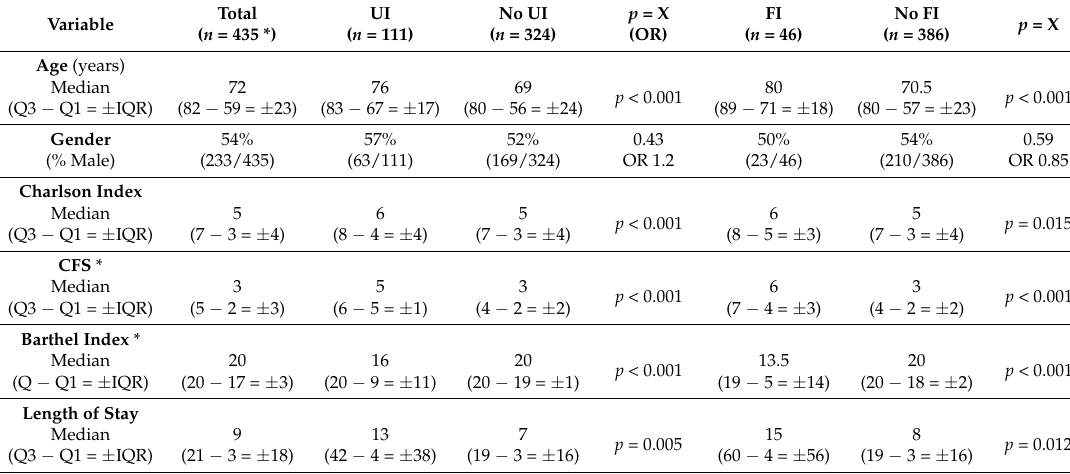
Table 1. Baseline characteristics of inpatients included in the incontinence point prevalence study by current urinary and faecal continence